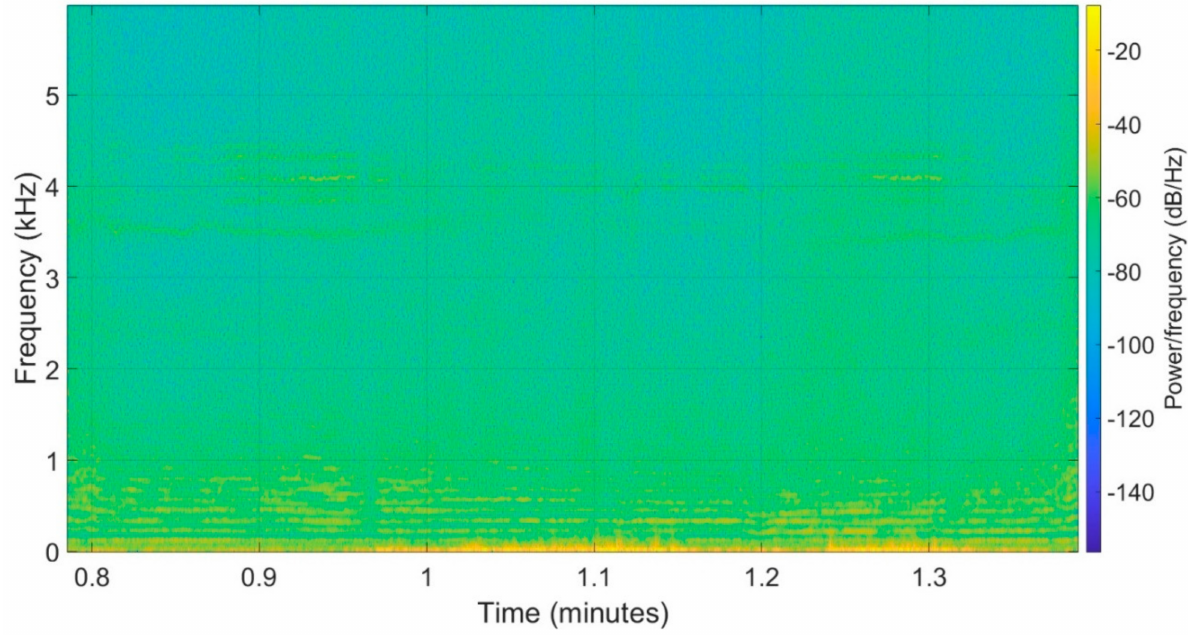
Figure 5. Spectrogram at the time when hexarotor is flying down (0.85–1 min), hovering (1–1.2 min), and flying up (1.2–1.4 min) closest to the microphone